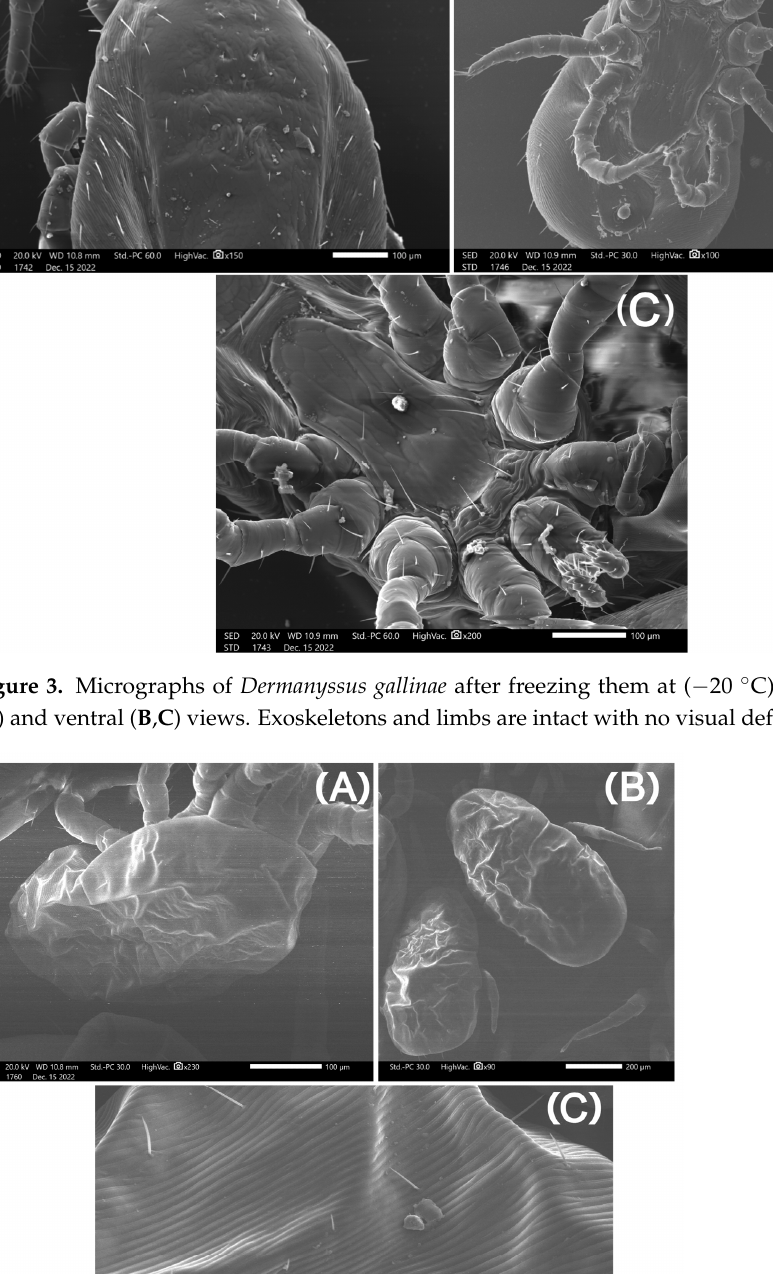
Figure 5. Micrographs of Dermanyssus gallinae after bioassays with AgNPs at 80 ppm for 1 day: ( A ) There are visible leg detachments (white arrows) and ( B ) considerable cracks throughout their exo ‐ skeleton (black arrow).